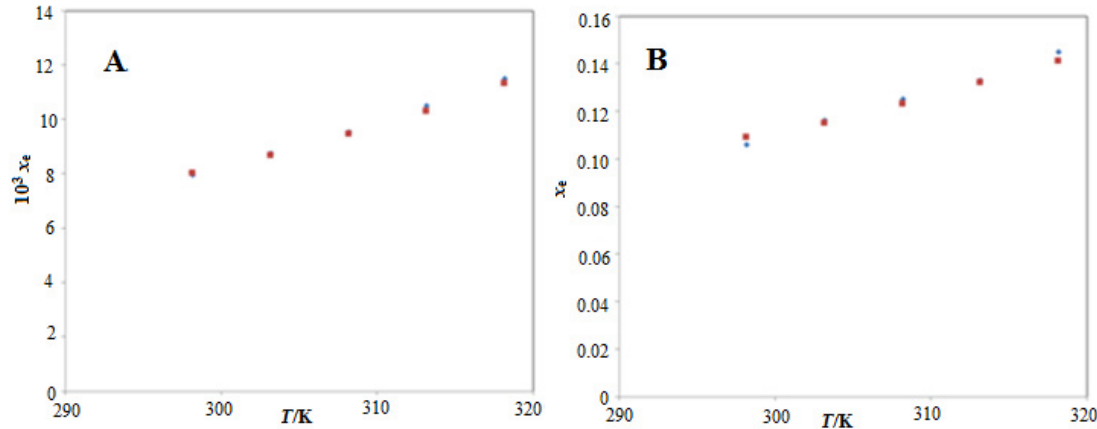
Figure 3. Comparison of mole fraction solubility values of ECT in ( A ) water and ( B ) PEG-400 with literature values at T = 298.2 K to 318.2 K; the symbol indicates the experimental mole fraction solubilities of ECT in (A) water and (B) PEG- 400 and the symbol indicates the literature solubilities of ECT in (A) water and (B) PEG-400 taken from reference [16].